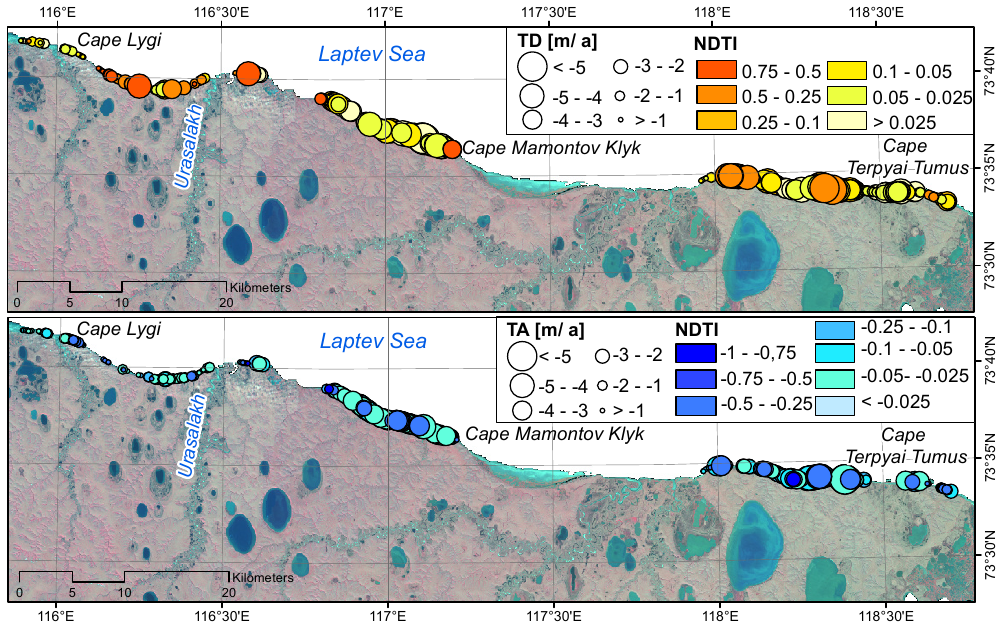
Fig. 4. Thematic map of coastal thermo-erosion transect data along the studied coastline of Mamontov Klyk (Anabar–Olenyok lowland). The upper map segment illustrates colour coded positive NDTI values associated with prevailing thermo-denudation (TD), the lower map illustrates colour coded negative NDTI values associated with prevailing thermo-abrasion (TA). The symbol size is equivalent to erosion values.